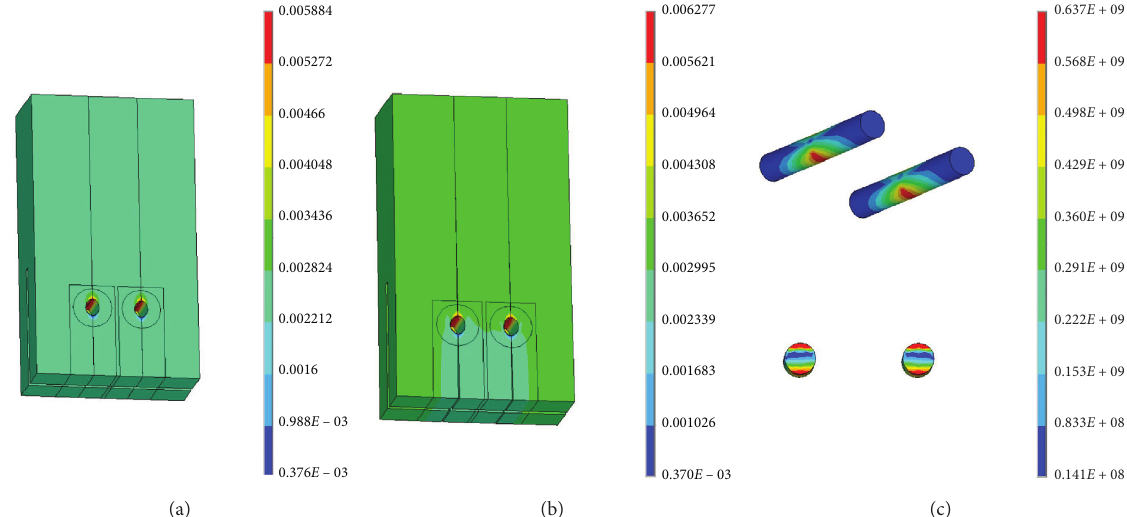
Figure 14: Failure mode of initially perfect Joint 2: (a) embedment deformation of wood; (b) splitting failure in the joint area; (c) von Mises stress distribution of